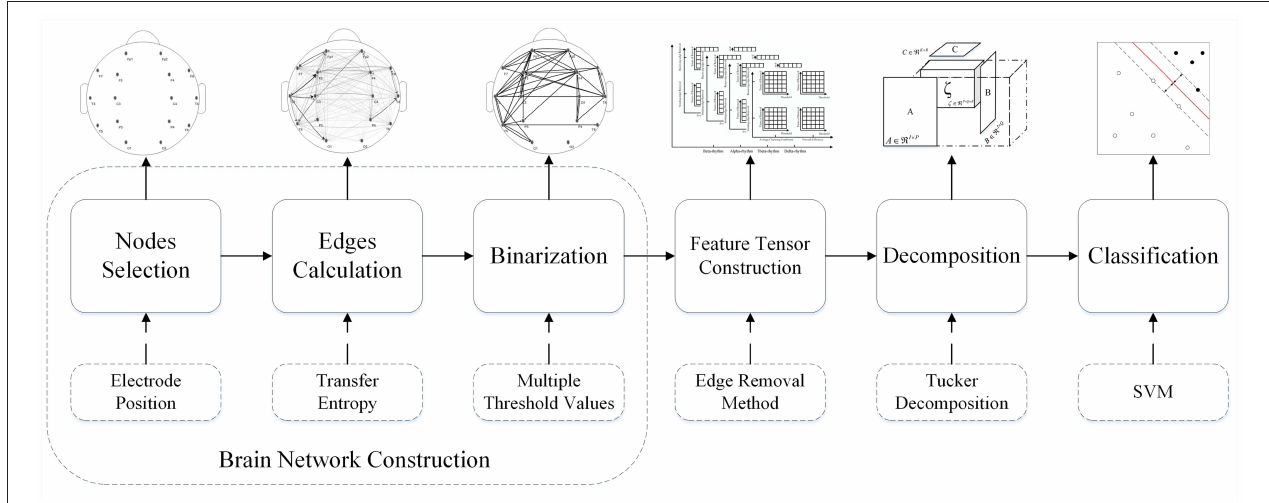
FIGURE 5 | Flowchart of the feature tensor-based epileptic detection model of brain networks based on edge removal.